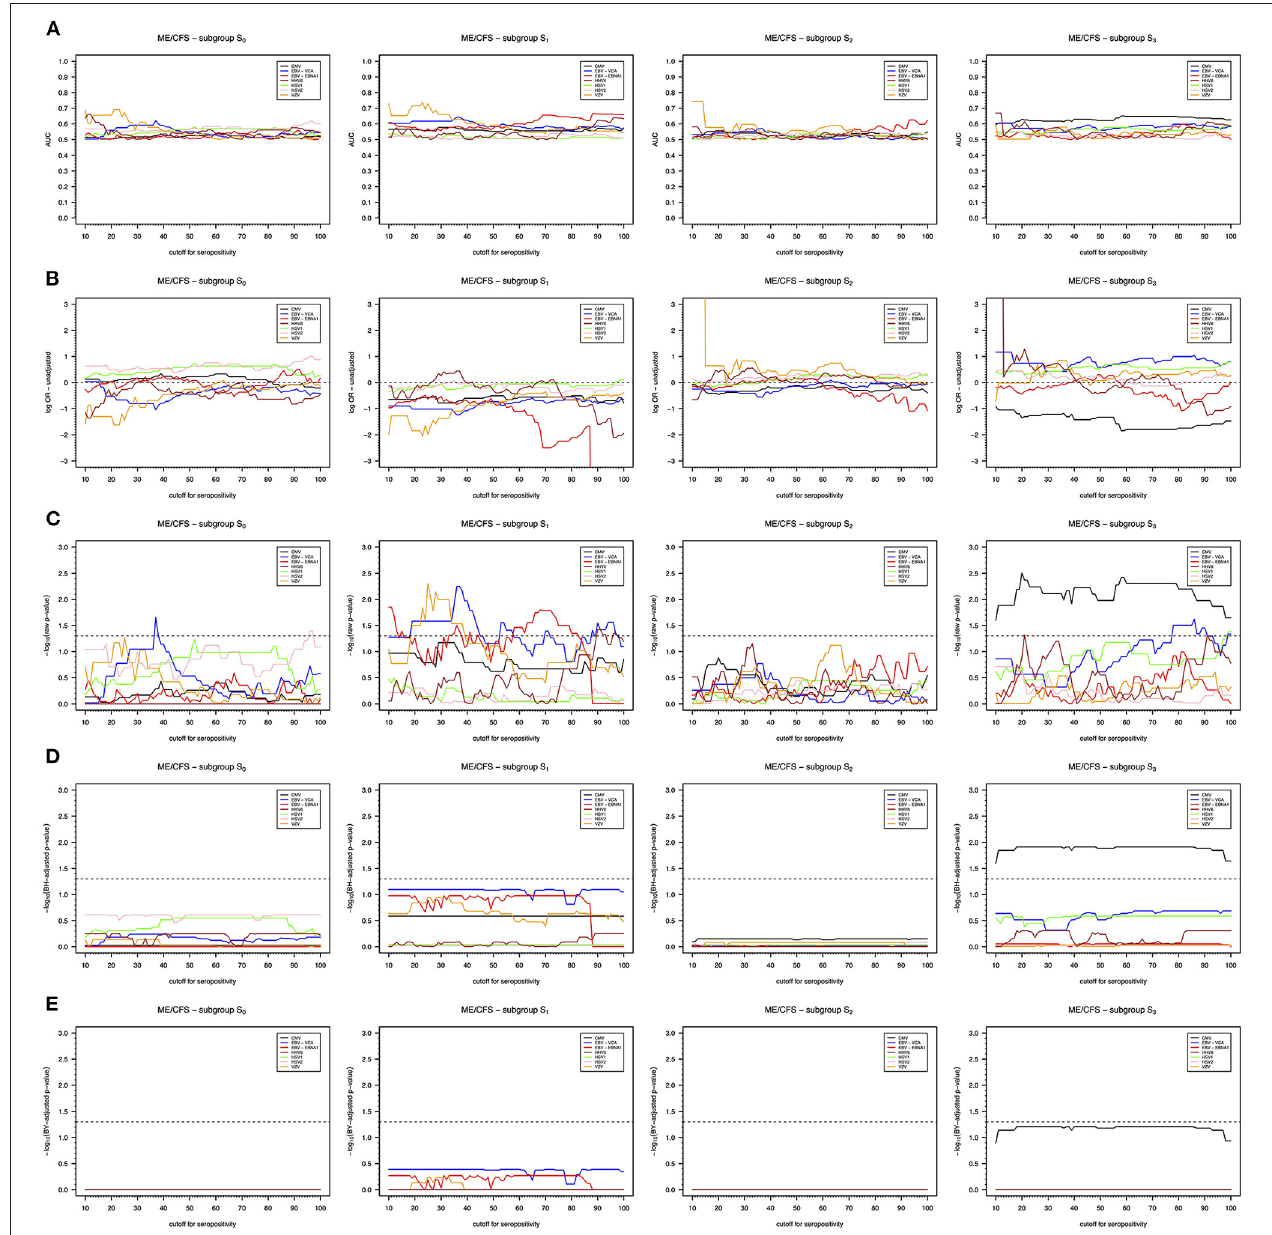
FIGURE 2 | Unadjusted association analysis of seropositivity to different herpesvirus antigens as function of the cutoff defining seropositivity. (A) AUC of the probabilities of being seropositive estimated in each subgroup of ME/CFS patients when compared to the same probabilities estimated in the group of healthy controls. (B) Log-ORs of being seropositive in each subgroup of ME/CFS patients in relation to the group of healthy controls. (C) Raw p -values of Wald’s score test for the significance of log-ORs. (D) The corresponding BH-adjusted p -values. (E) The corresponding BY-adjusted p -values. For convenience, raw and adjusted p -values were transformed as –log 10 ( p -value). The dashed lines in the respective plots represent the threshold referring to the 5% significance level [i.e., –log 10 (0.05); C ] or the 5% false discovery rate. (D,E) Cutoff values in which –log 10 ( p -values) are above these thresholds provided evidence for significant